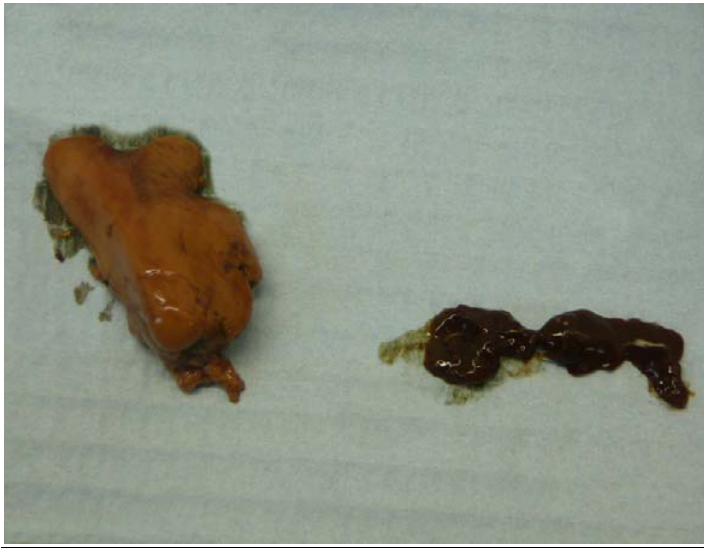
Figure 3. Mullet livers, fish captured 7 September 2009. Left: Partial liver from study lake specimen. Right: Entire liver from control lake specimen. While the liver of the study lake specimen appeared to be grossly enlarged at necropsy, the two livers presented here are from fish of different size classes, so this image should not be used to draw conclusions on relative liver